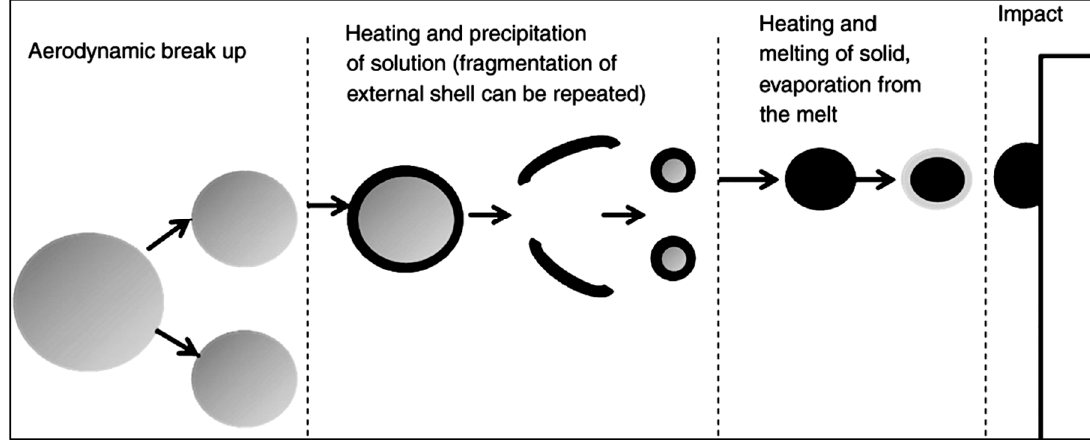
Figure 7. Phenomena occurring in plasma jet during SPPS process [75]. Reproduced with permission from [Surface and Coatings Technology], Elsevier, 2009.